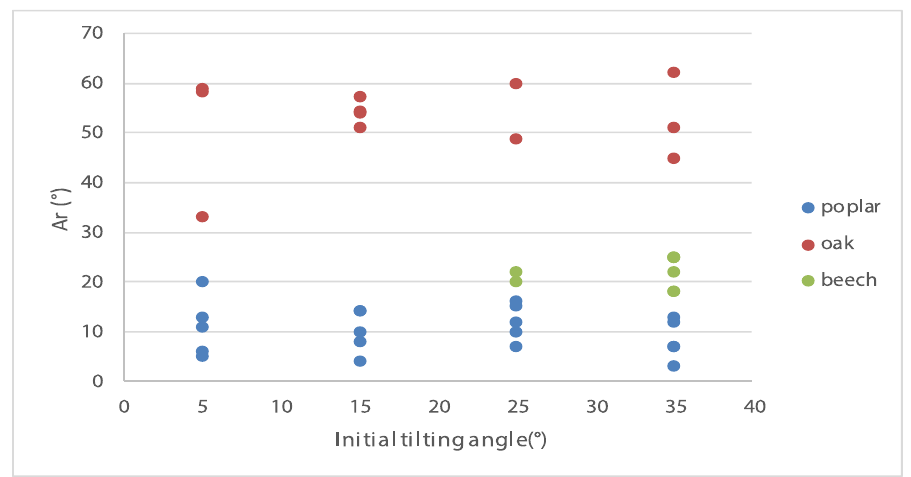
Fig 9. Values of Ar as a function of the initial angle of tilting from the vertical, for poplar, oak and beech. Note: for beech only, Ar values for a tilting angle larger than 20˚ from the vertical are presented because a tilting angle of less than 20˚ engendered no movement of the